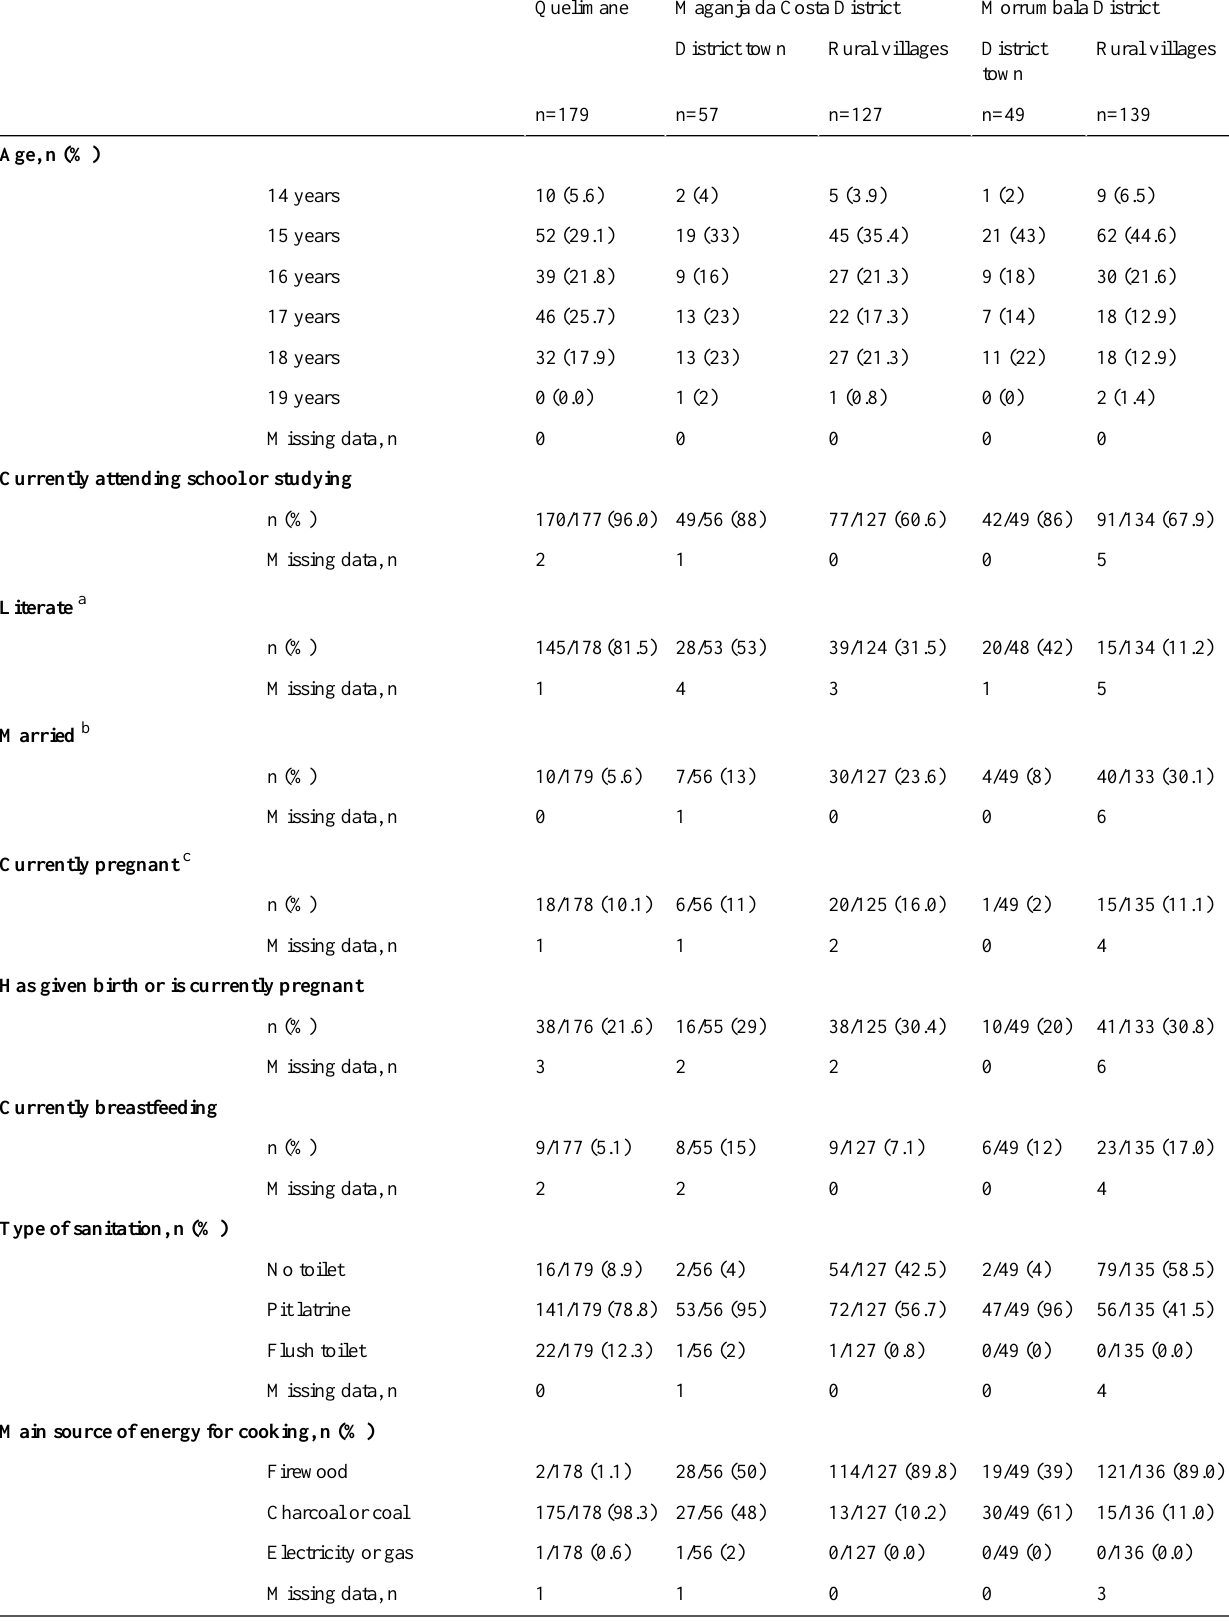
Morrumbala DistrictMaganja da Costa DistrictQuelimane